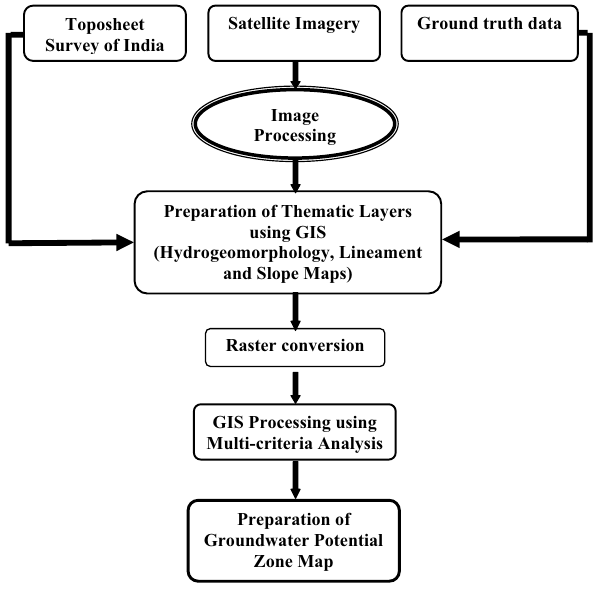
Fig. 3 Flow chart showing the steps followed in delineating ground- water potential zone